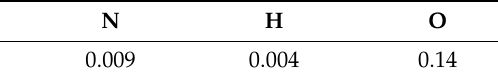
Table 1. Chemical composition of TC4 alloy (wt, %).